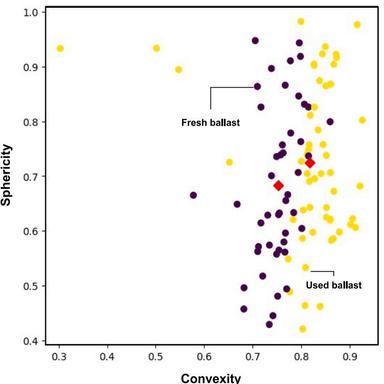
Clustering of fresh and used ballast by (a) Orange software and (b) K-means algorithm. (For interpretation of the references to color in this figure legend, the reader is referred to the web version of this article.)